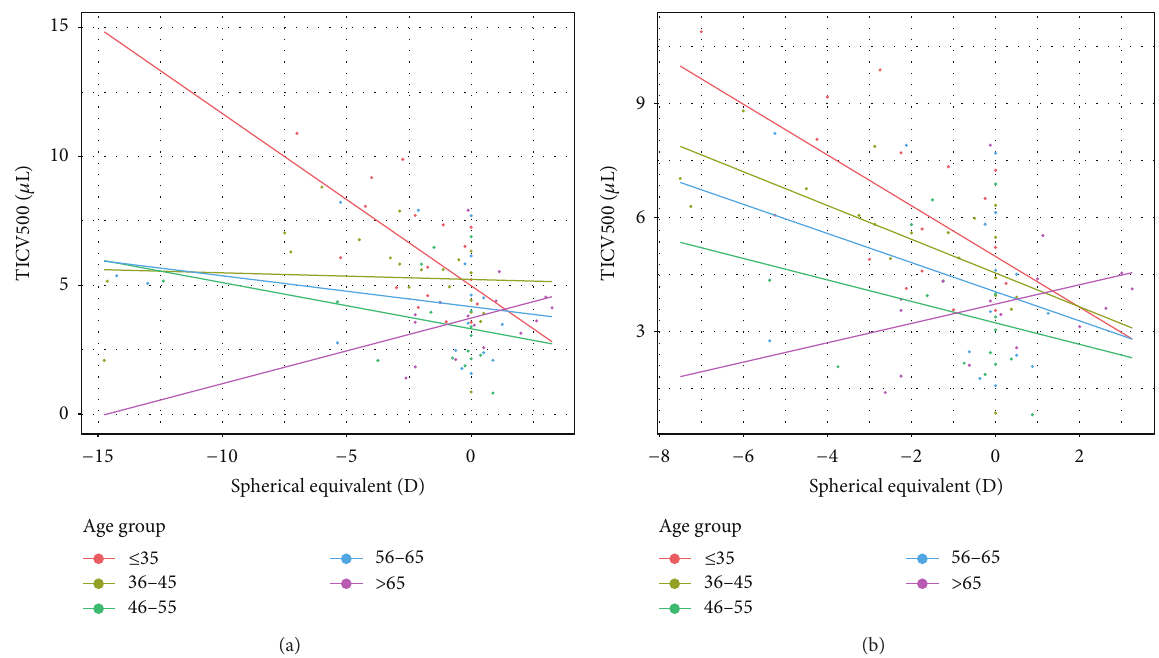
Figure 4: (a) TICV500 versus spherical equivalent scatter plot with estimated regression line for each group (with outliers). (b) TICV500 versus spherical equivalent scatter plot with estimated regression line for each group (without